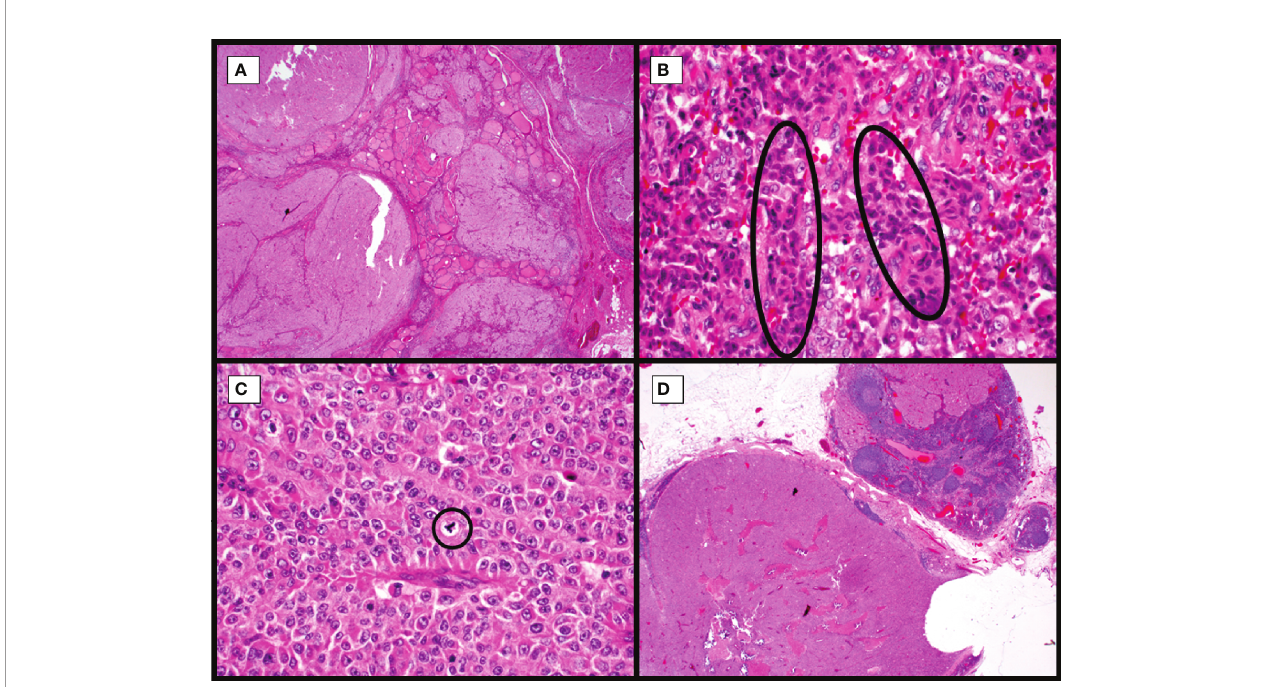
FIGURE 3 | Widely invasive Hürthle cell carcinoma with high-grade features, hematoxylin and eosin stain. Multinodular growth of the Hurthle cell carcinoma into adjacent thyroid with no circumscription leads to non-controversial diagnosis of widely invasive Hurthle cell carcinoma ( A , 40X). Collections of hyperchromatic, irregularly shaped nuclei with hypereosinophilic colloid, so-called burgeoning or incipient necrosis ( B , circles, 400X). Frequent mitoses and scattered irregular (tripolar) mitoses ( C , circle, 400X) and variably retained prominent nucleoli. Tumor metastasis to lateral neck lymph nodes ( D , 20X), following a typical pattern of metastasis in Hürthle cell